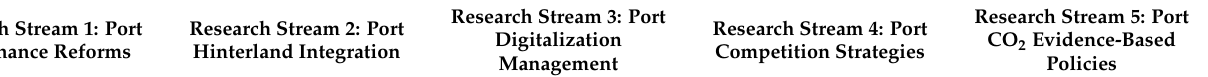
Table A1. The 30 selected scientific articles belonging to each research